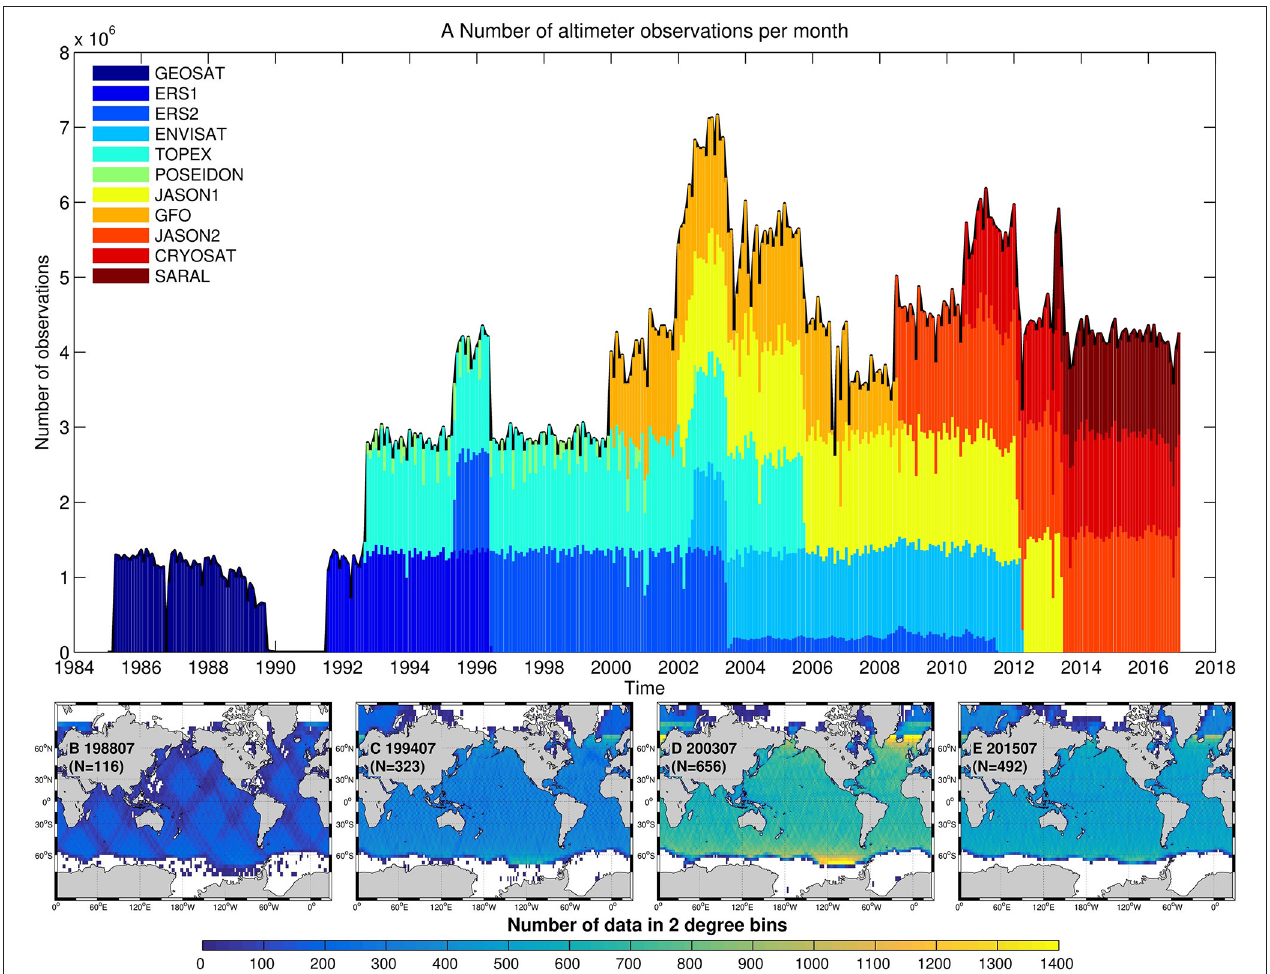
FIGURE 8 | Number of radar altimetry 1 Hz observations per month (A) . The lower panels show the number of observations in 2 × 2 longitude-latitude bins for July (B) 1988 (GEOSAT) (C) 1994 (ERS-1, Topex-Poseidon (D) 2003 (ERS-2, Envisat, Topex-Poseidon, Jason-1, GFO), and (E) 2015 (Jason-2, Cryosat-2,